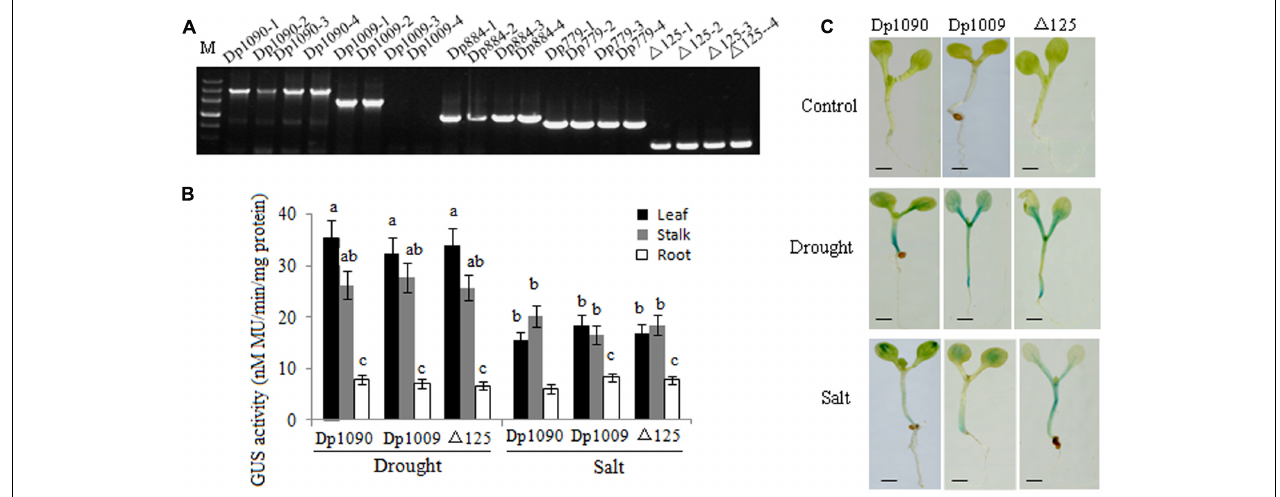
FIGURE 5 | TaSnRK2.8 promoter region from –693 to –568 (125 bp) is required for osmotic stress response. (A) DNA-PCR analysis of transgenic plants. (B) Effects of osmotic stress on GUS activity under the control of different TaSnRK2.8 promoter deletion segments. The plants used for the analysis were two independent lines carrying the promoter deletion constructs. GUS activity was expressed as nM MU/min/mg protein. Values are the mean ± SE ( n = 20). a – c Values followed by the different letter are significantly different ( P < 0.05). (C) The GUS staining of transgenic Arabidopsis seedlings containing promoter deletion constructs under normal and osmotic stress conditions. The 7-day-old seedlings were planted on the MS medium containing 150 mM NaCl (salt) or 150 mM mannitol (drought). –774 to ATG, Dp1090; –693 to ATG, Dp1009; –568 to ATG, Dp884; –463 to ATG, Dp779; –408 to ATG, Dp724; Dp724 carrying the 125-bp fragment from –693 to –568 bp, (cid:49) 125. Bar, 2